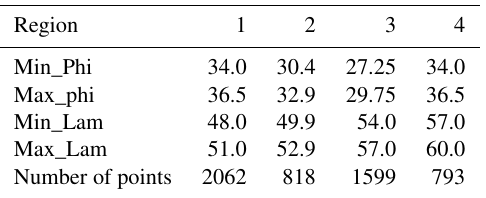
Figure 1. Distribution of gravity data over Iran (green dots). Topog- raphy as background (m). Table 1. Location of each region based on geographical coordinates and corresponding number of observations.